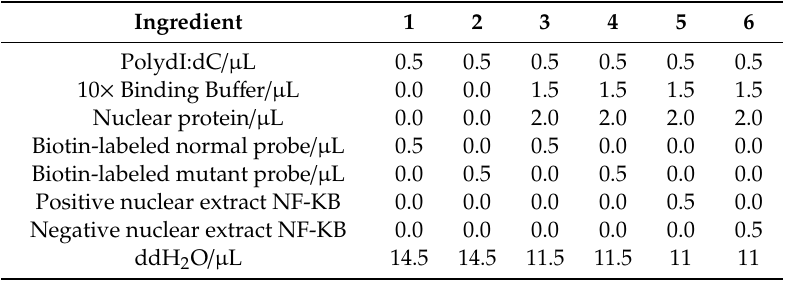
Table 6. EMSA reaction system.